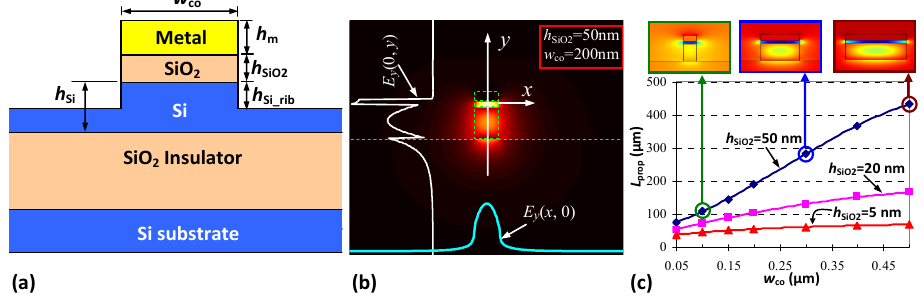
Figure 1. ( a ) The cross section of the present hybrid plasmonic waveguide with a metal cap on a silicon-on-insulator rib; ( b ) The calculated field distribution for the major component E y ( x , y ) of the quasi-TM fundamental mode of the present hybrid plasmonic waveguide; ( c ) The dependence of propagation distance L prop on the core with w co , when the thicknesses of SiO 2 are h SiO2 = 5, 20, 50 nm respectively (insets: the field profiles) [12].